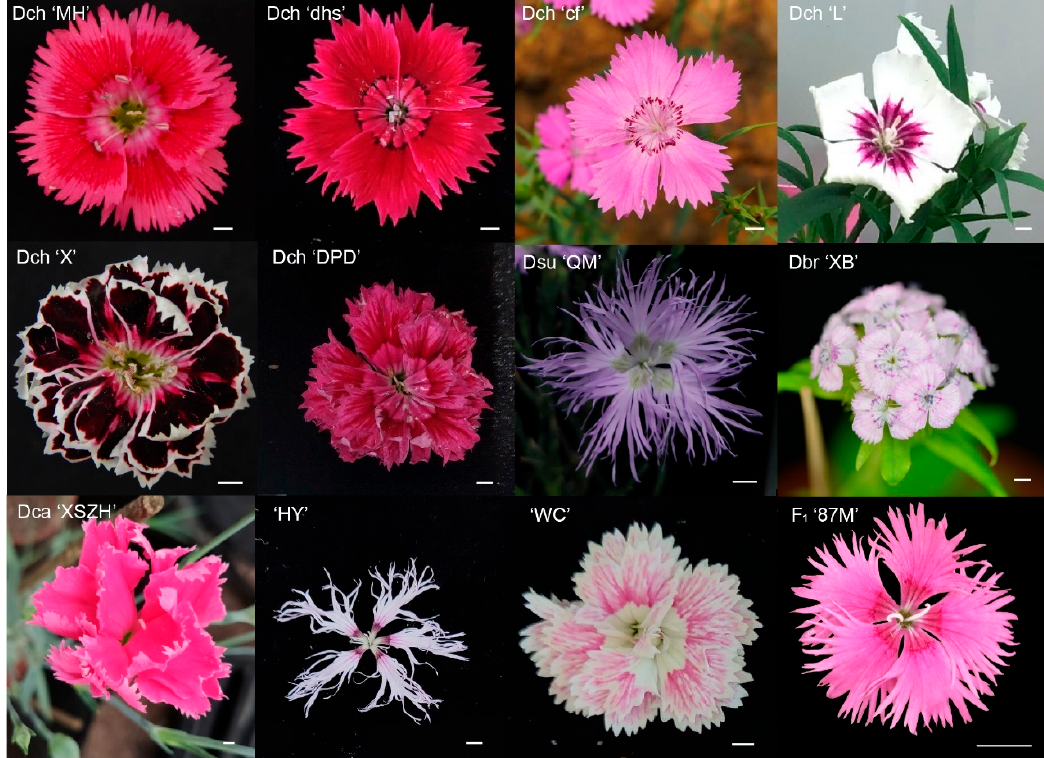
Figure 1. Morphological characteristics of flowers of Dianthus species in this study. Scale bar = 1 cm.